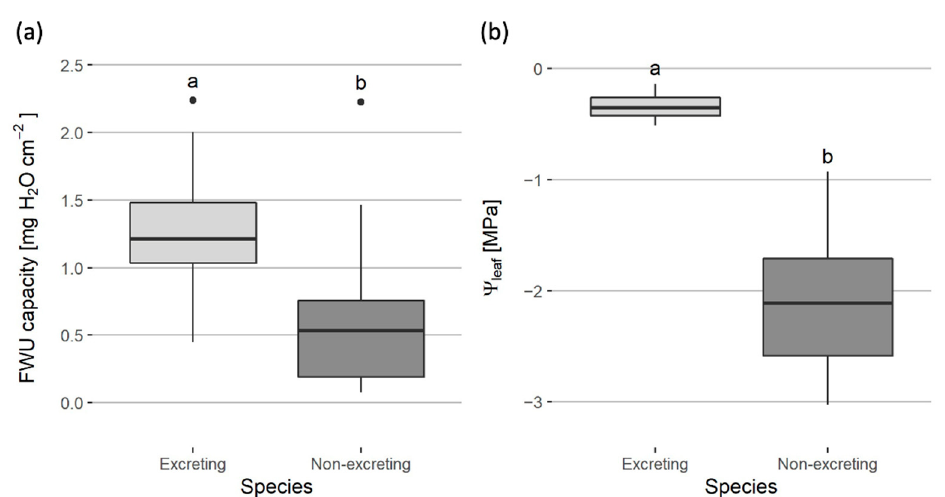
Figure 4. Box plots of the leaf parameters for salt-excreting and non-salt-excreting species with the following parameters of study: ( a ) foliar water uptake (FWU) capacity and ( b ) leaf water potential ( Ψ leaf ). The excretors consist of the species Avicennia marina and Aegiceras corniculatum , the non-excretors of the species Bruguiera cylindrica , Bruguiera gymnorhiza , Sonneratia alba and Sonneratia caseolaris . Box plot midlines are medians, and box edges show first and third quartiles, with whiskers representing minimum and maximum values. Circles indicate outliers in the dataset. Letters at the top of the box plots indicate differences of significance ( p < 0.05) among groups based on Welch t -tests, for which data of FWU capacity were